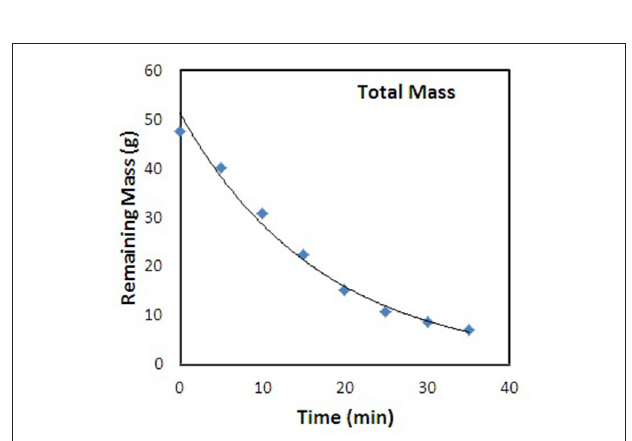
FIGURE 5 | Total mass of salt remained in the wellbore as a function of time for the ARH well (the point shows the data, and the line indicates the trend).